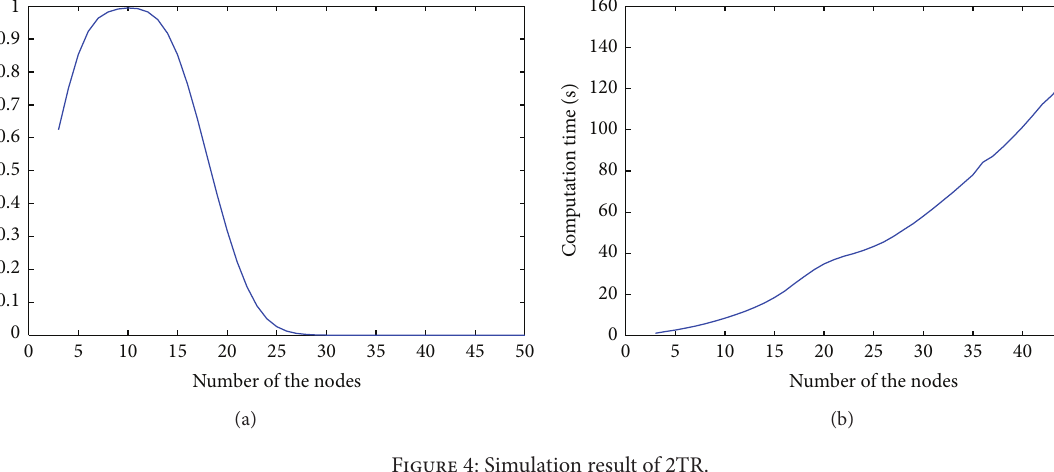
Figure 4: Simulation result of 2TR.